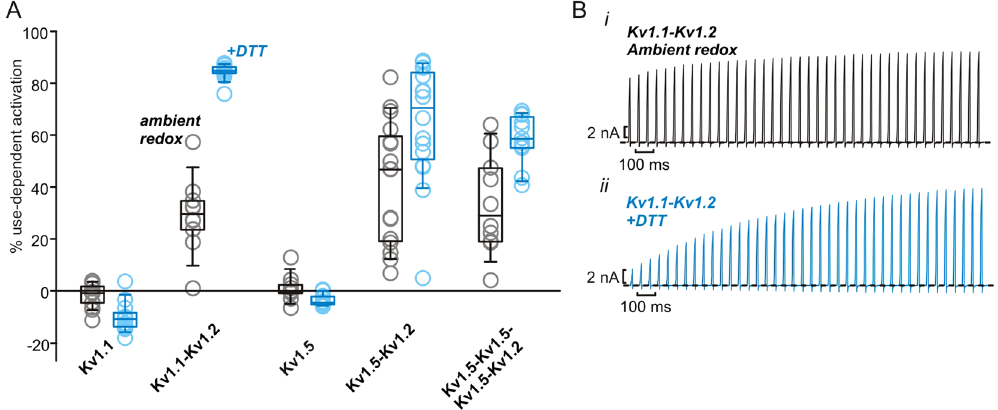
Figure 3. Redox-sensitive use-dependence is transferrable in heteromeric channels containing Kv1.2 subunits. ( A ) Repetitive depolarizations were used to assess % use-dependent activation, as described in Fig. 1B, for a variety of Kv1 channel subtypes and concatenated combinations with Kv1.2 as indicated. Each data point reflects the % use-dependence recorded from an individual cell in ambient redox conditions (gray) or in the presence of either 666 µ M or 2 mM DTT (blue). N = 10–17 for each construct and condition. ( B ) Exemplar current tracings illustrating use-dependent activation of Kv1.1-Kv1.2 dimeric channels in (i) ambient redox conditions or (ii) 666 µ M